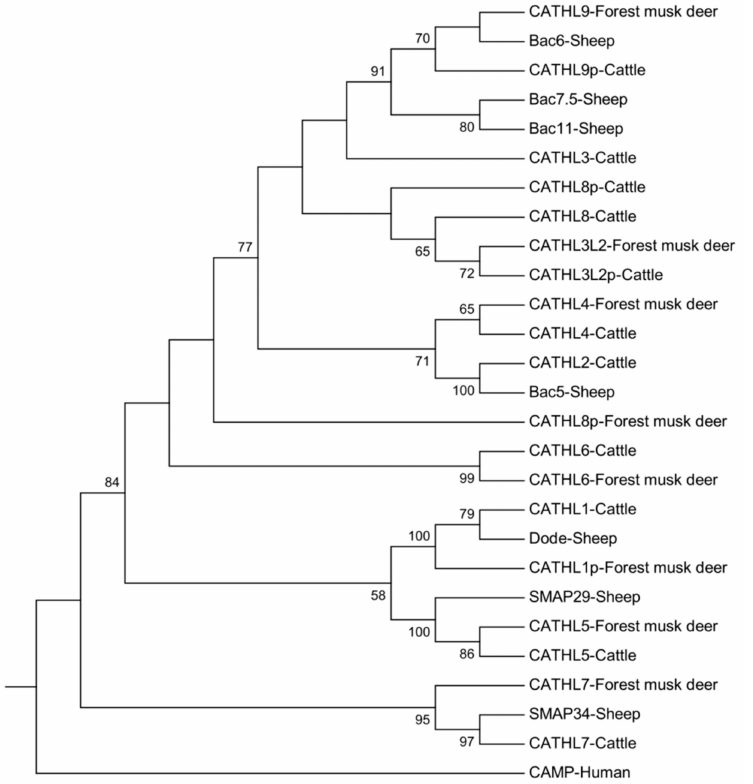
Figure 2. Phylogenetic relationships of the forest musk deer cathelicidins. Amino acid sequences of the forest musk deer cathelicidins were compared with sequences from other representative species. The phylogenetic tree was conducted by the neighbor-joining method with bootstrapping (1000 iterations). Only the bootstrap values higher than 50 are shown above